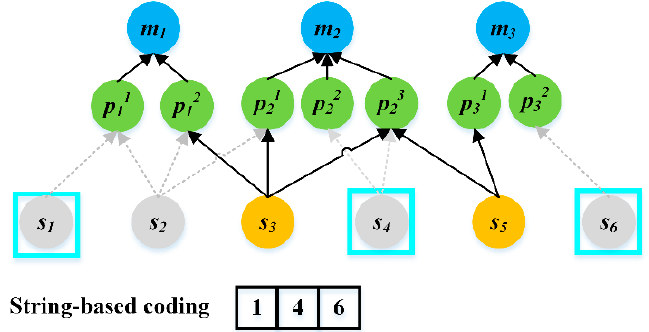
Figure 4. String-based solution coding.